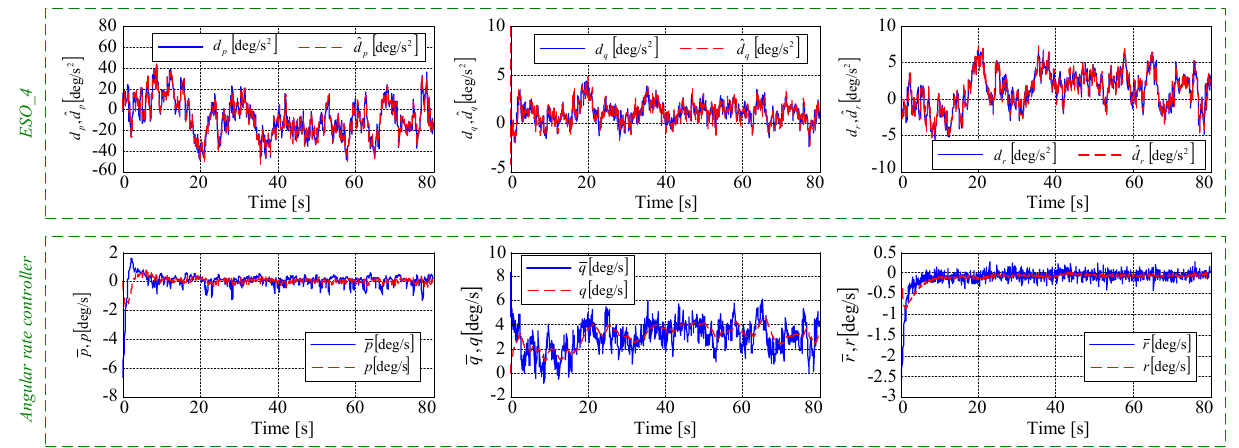
of the scheme from Figure 4; (ii) the real time varying trajectory of the aircraft tends to its reference time varying trajectory, thus proving not only the accuracy of the backstepping controllers but also their robustness with respect to the disturbances considered in this work (airwake, shears, atmospheric turbulences, wind gusts); (iii) the airplane achieves a safe landing in the presence of deck motion (see Figure 6), carrier airwake, and other wind type disturbances (see Figure 5); (iv) under the proposed ACLS, although the desired touchdown point has oscillations in vertical and lateral planes, the airplane motion overlaps the carrier motion, successfully capturing the time-varying reference trajectory; (v) due to the presence in the ACLS of the blocks for the prediction and compensation of the deck motion, the glide path commands are corrected, thus enhancing the accuracy of the guidance control scheme; (vi) the transition from glideslope phase to touchdown phase is continuous and smooth, the stability of the system being not altered. Figure 12. Trajectory of aircraft and carrier. Figures 5–12 have been drawn for moderate sea, light wind shears, light atmospheric turbulences, and light gusts. Now, it is interesting to see how the intensity of the airwake (quantified by the sea state) and the intensity of the wind influence the aircraft landing point.